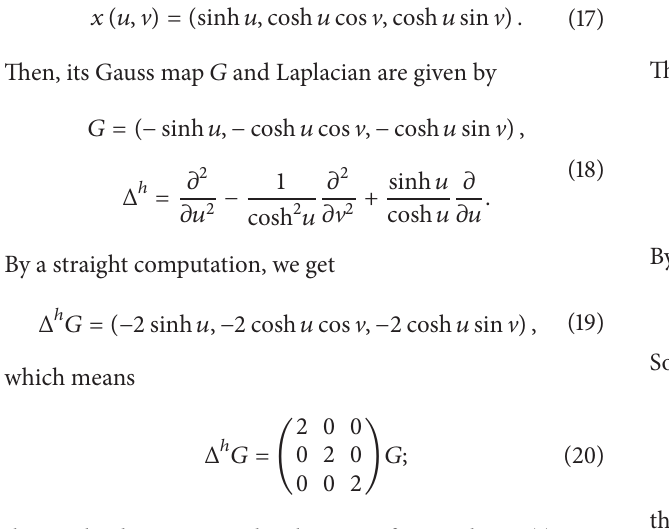
Figure 4: The future hyperbolic